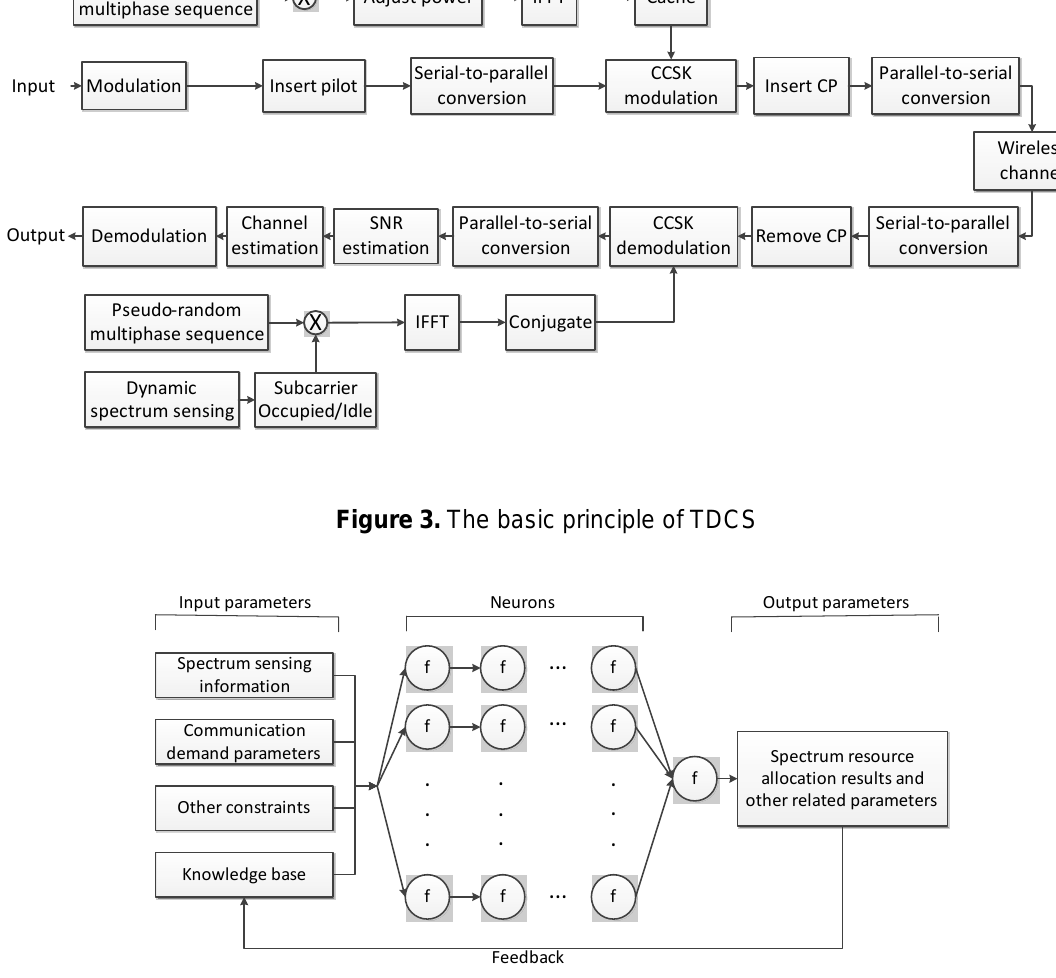
Figure 4. The basic principle of artificial intelligence